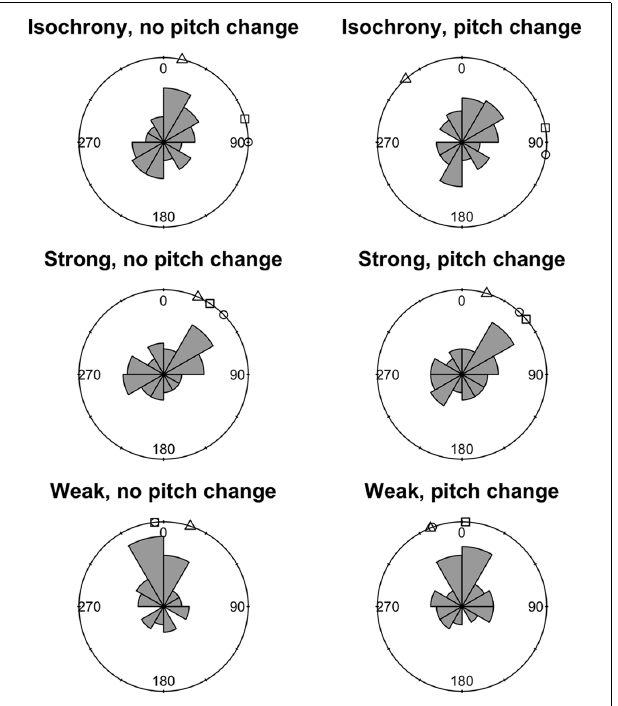
FIGURE 3 | Mean circular asynchronies for the three dysrhythmic participants compared to the control group in all six conditions of the synchronization task. Circular histograms depict frequency density of mean asynchronies around a circle.Values close to 0 ◦ indicate tapping close to the correct tap time, while values close to 180 ◦ indicate tapping halfway between the correct times. (cid:3) = SS; ◦ = SWI; (cid:4) = VPO.